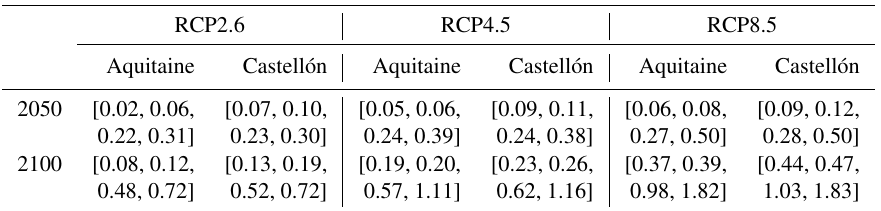
Table 2. RSLR (in metres) projections in Aquitaine and Castellón for the RCP2.6, RCP4.5 and RCP8.5 scenarios in 2050 and 2100. RSLC projections are expressed as changes with respect to the year 2015. The first and fourth values in brackets correspond to RSLC estimates that define the support of the trapezoid (associated with a possibility degree of 0), and the second and third values in brackets correspond to RSLC estimates that define the core of the trapezoid (associated with a possibility degree of 1).